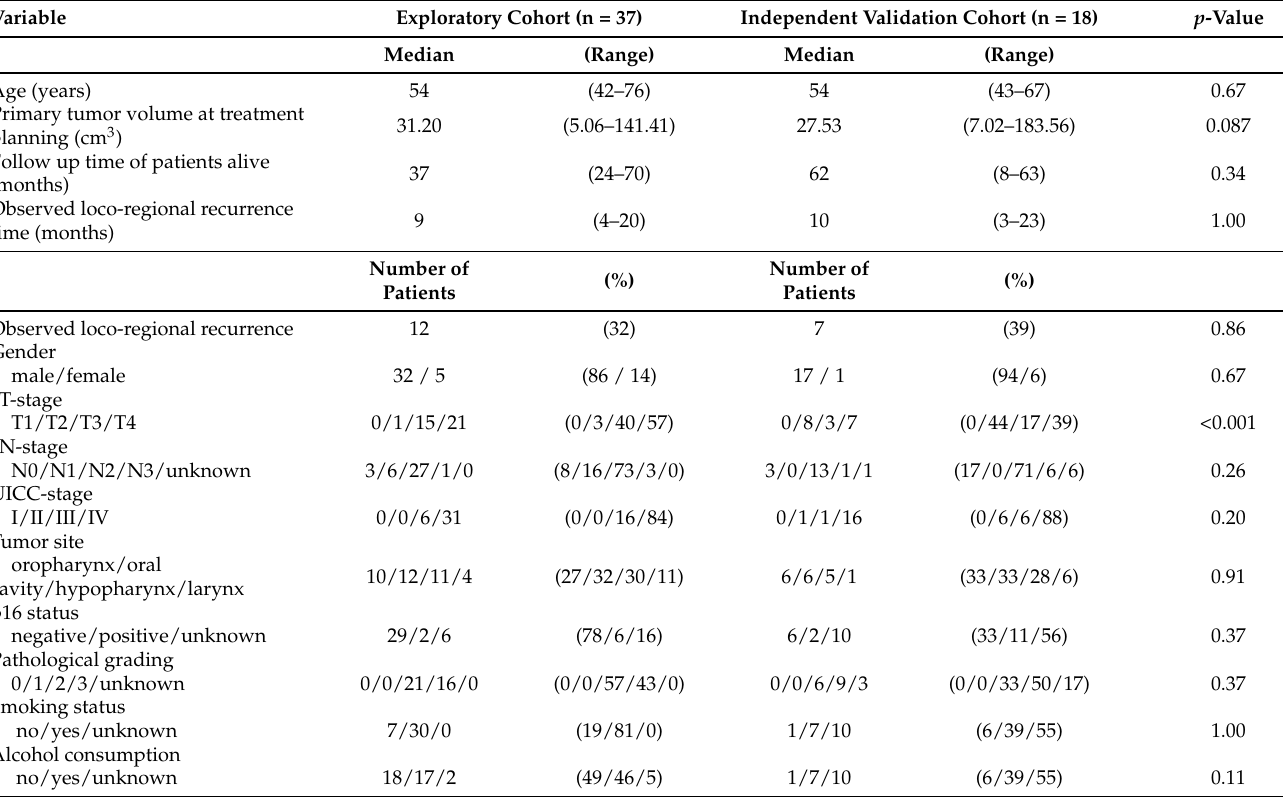
Table 2. Patient characteristics of the exploratory and independent validation cohort: p -values were obtained using two-sided Mann–Whitney U-tests for continuous variables and χ 2 homogeneity tests for categorical